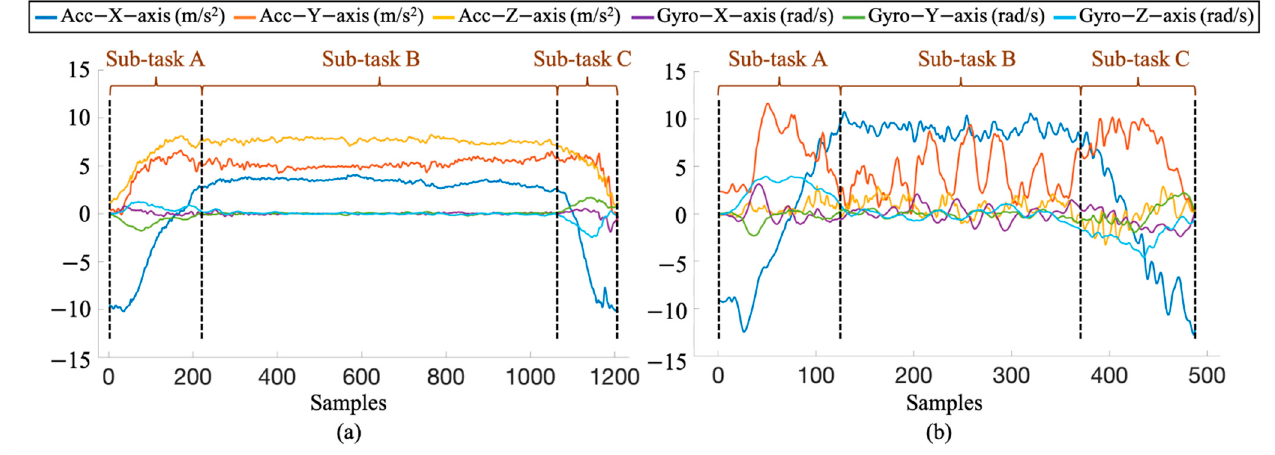
Figure 10. An example of the data of the T2 task “cleaning upper back and shoulder” collected from the wrist-worn sensor, which are performed by ( a ) the FS patient and ( b )the healthy subject.